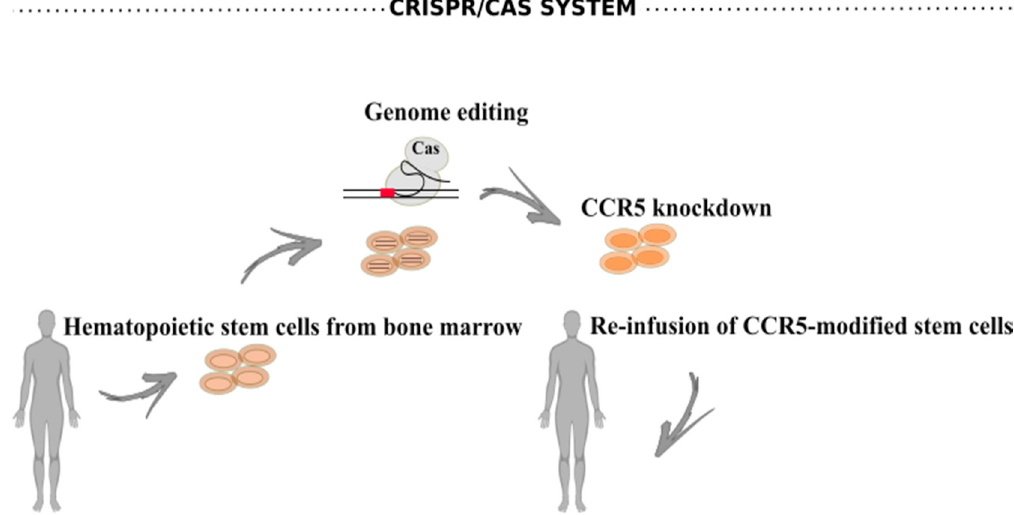
Figure 5. CRISPR / Cas system to generate CCR5-resistant stem cells. Hematopoietic stem cells are collected from bone marrow of infected individuals. These cells are expanded ex vivo upon genome editing by the CRISPR / Cas system targeting the CCR5 co-receptor. Subsequently, the CCR5-modified stem cells are infused back to the same